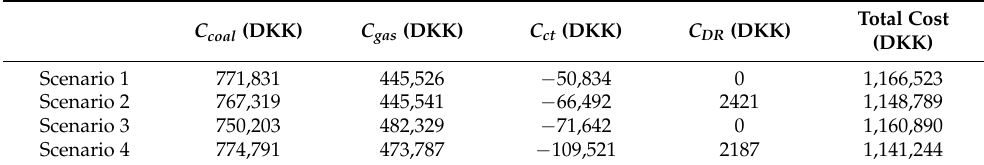
Table 3. Operating costs and carbon emission of different